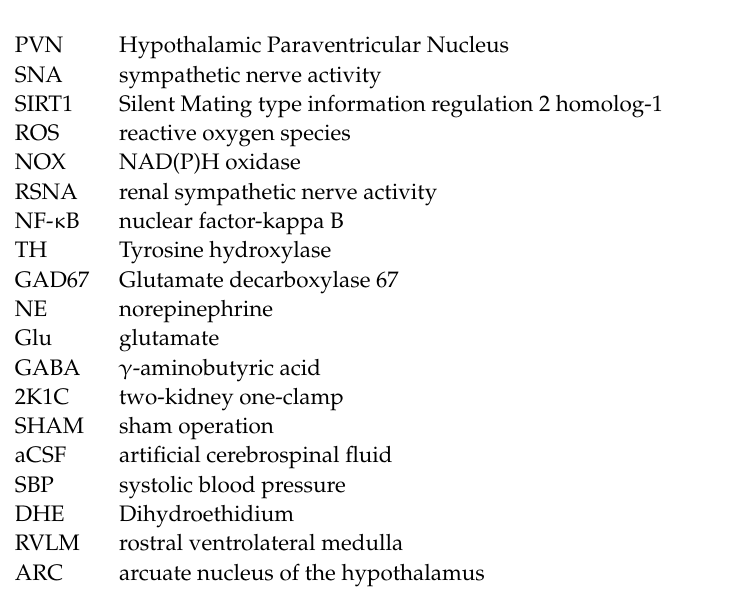
Figure S2: Resveratrol increased SOD1 protein expression of 2K1C